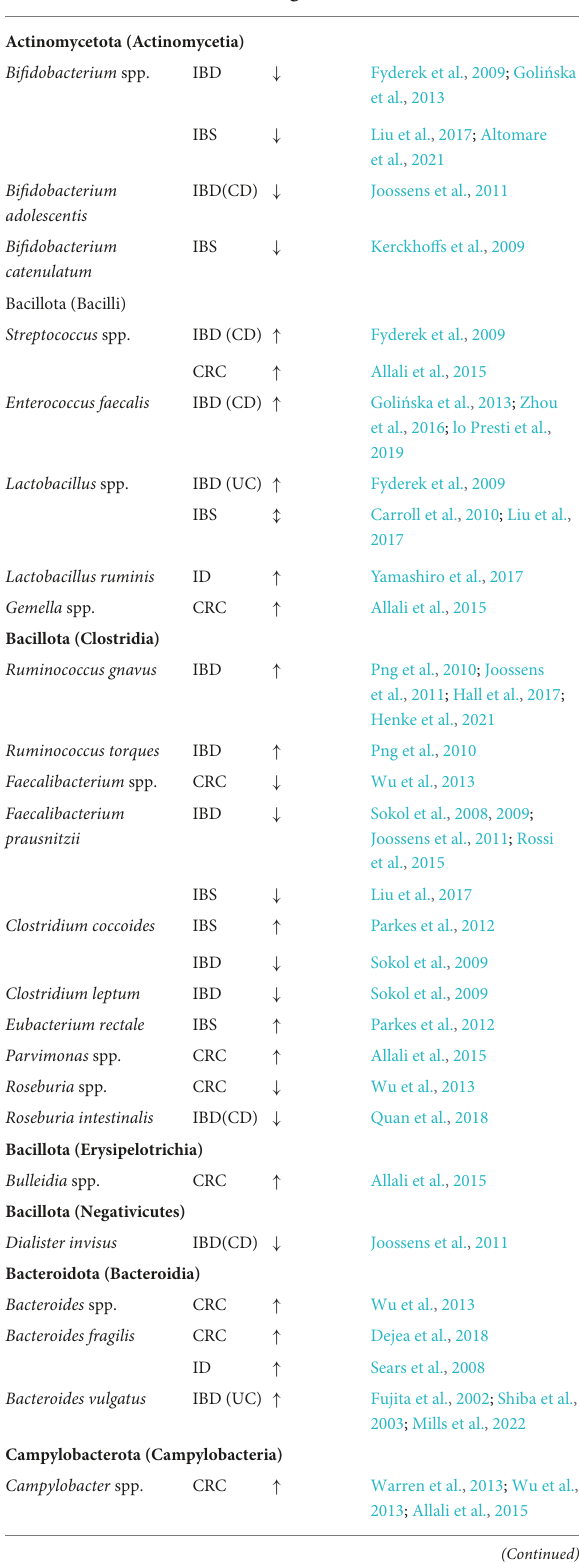
TABLE 1 Summary of bacterial genera/species signatures associated with inflammatory diseases, organized as Phylum